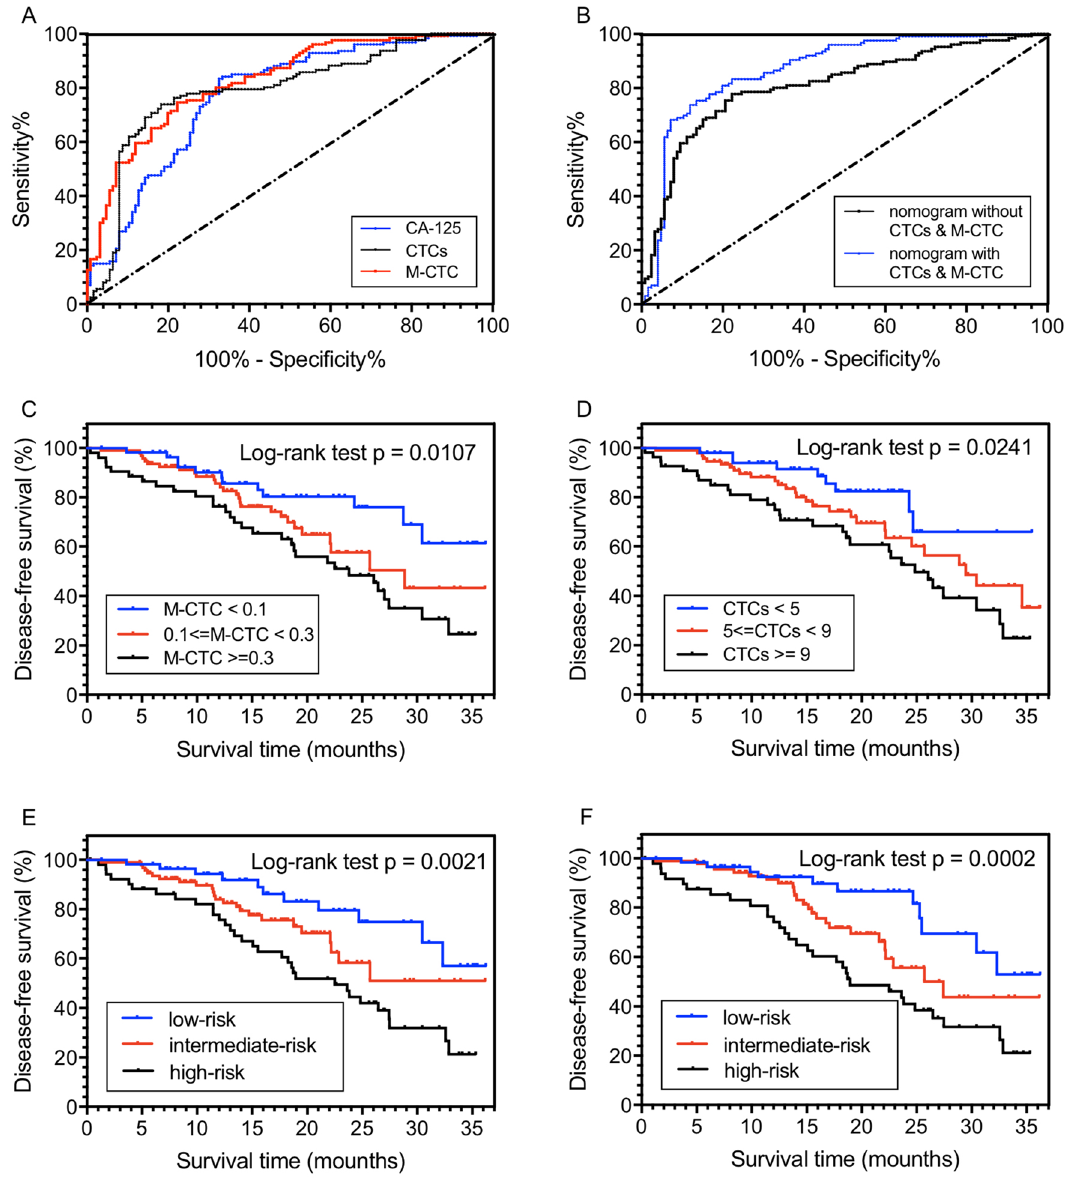
Figure 4. The receive operating characteristic (ROC) curve of patients stratified by ( A ) CTC counts, M-CTC percentage, and CA-125; ( B ) nomogram-based risk groups The Kaplan–Meier curves for DFS of all the patients involved stratified by ( C ) M-CTC percentage; ( D ) CTC counts and risk groups of the nomogram ( E ) without or ( F ) with CTC counts and M-CTC